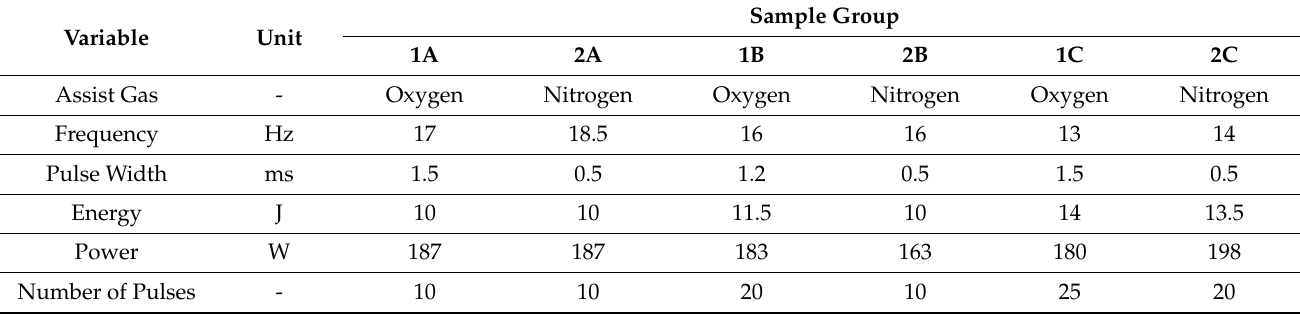
Table 3. Process parameters of laser beam drilling used on all applicable material thicknesses for both long and short cycles. Variable